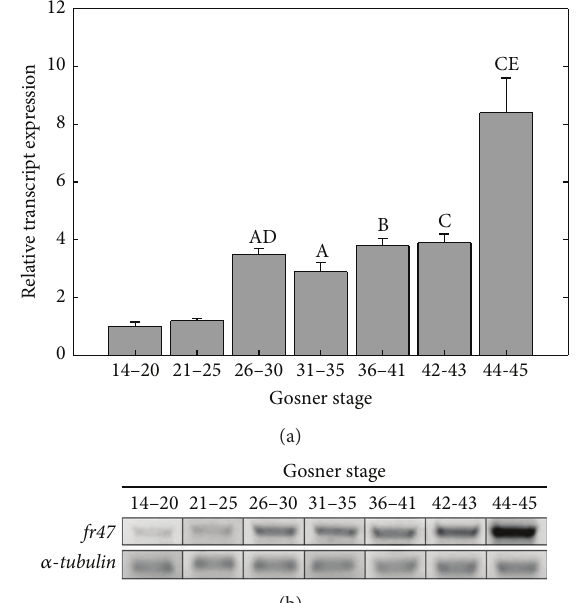
Figure 6: Relative fr47 transcript expression during stages of tad- pole development in wood frogs. (a) Histogram shows mean values ( ± SEM, 𝑛 = 4 -5 independent determinations) for fr47 . (b) Rep- resentative fr47 and 𝛼 - tubulin bands used for quantification. Data was analyzed using analysis of variance with a post hoc Student- Newman-Keuls test where the letters “A,” “B,” and “C” represent significant differences between Gosner stages 14–20 and later stages, whereas “D” and “E” indicate significant differences between the indicated stage and the one preceding it; “A” and “D” indicate 𝑃 < 0.05 and “B” indicates 𝑃 < 0.01 , while “C” and “E” indicate 𝑃 < 0.005